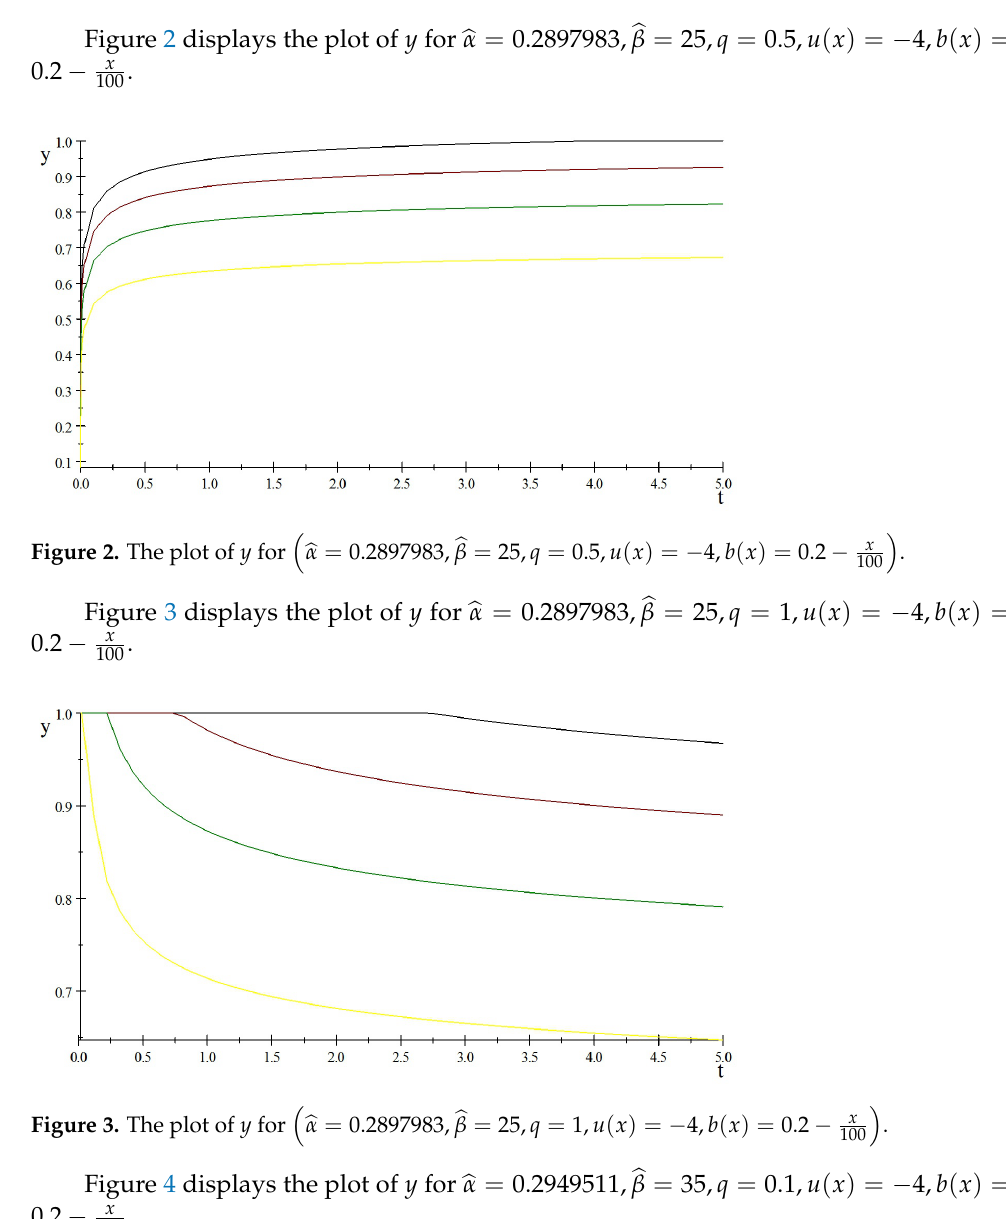
(cid:16) Figure 3. The plot of y for (cid:98) α = 0.2897983, (cid:98) β = 25, q = 1, u ( x ) = − 4, b ( x ) = 0.2 − Figure 4 displays the plot of y for (cid:98) α = 0.2949511, (cid:98) β = 35, q = 0.1, u ( x ) = − 4, b ( x ) = 0.2 − x . 100